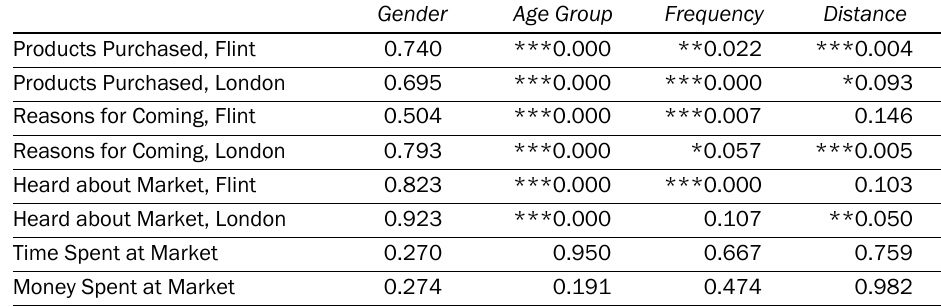
Table 2. Chi-Squared Significance Values for Customer Characteristics